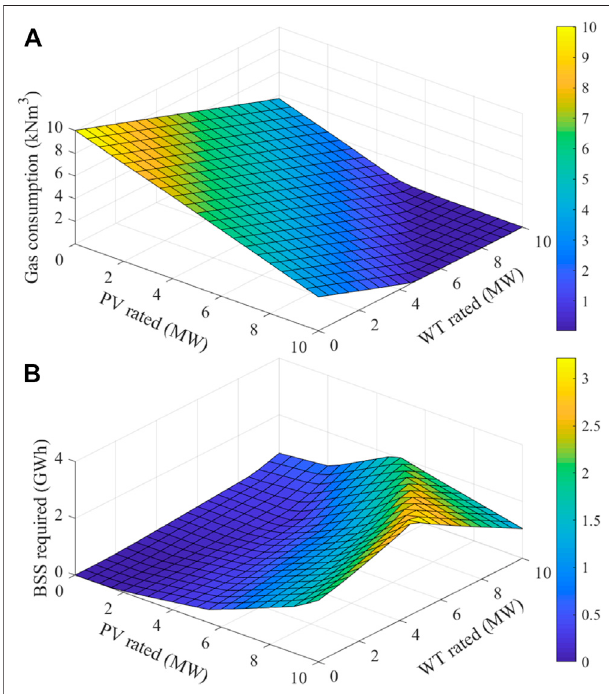
FIGURE 6 | Boiler gas consumption and required BSS capacity according to the rated power of PV and WT.